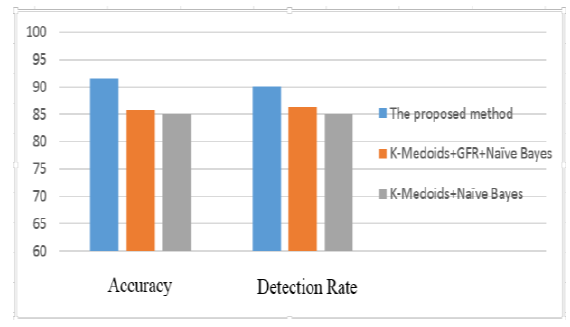
Figure 2. Comparison between detection rate and accuracy among proposed method, K- Medoids+GFR+Naïve Bayes, and K-Medoids+Naïve Bayes. Table 6 represents the results across accuracy,